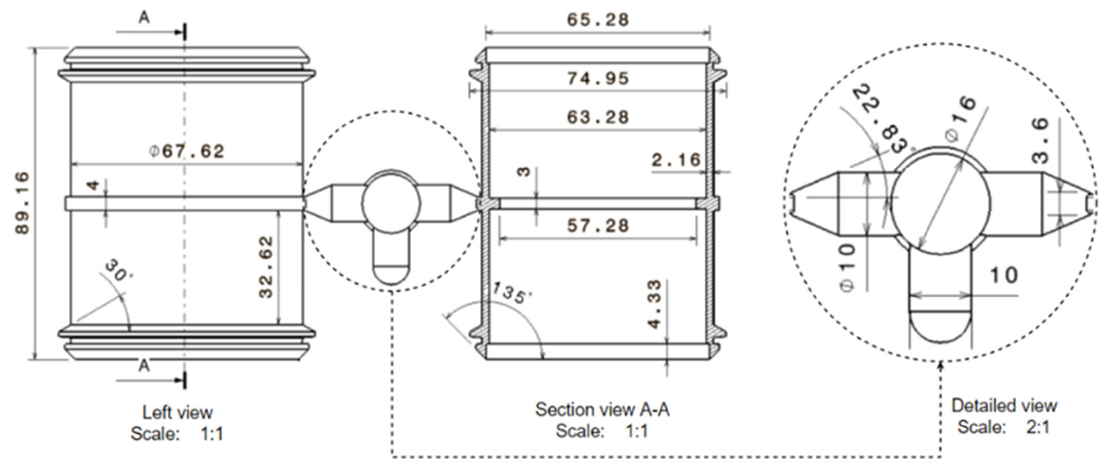
Figure 1. Bushing geometry and dimensions of runner system of the original mold.